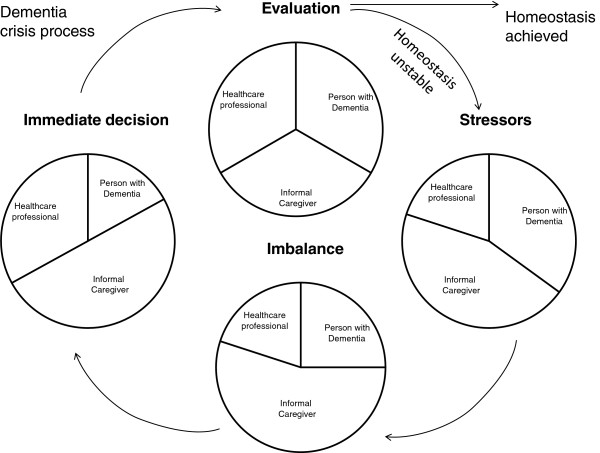
Literature search.